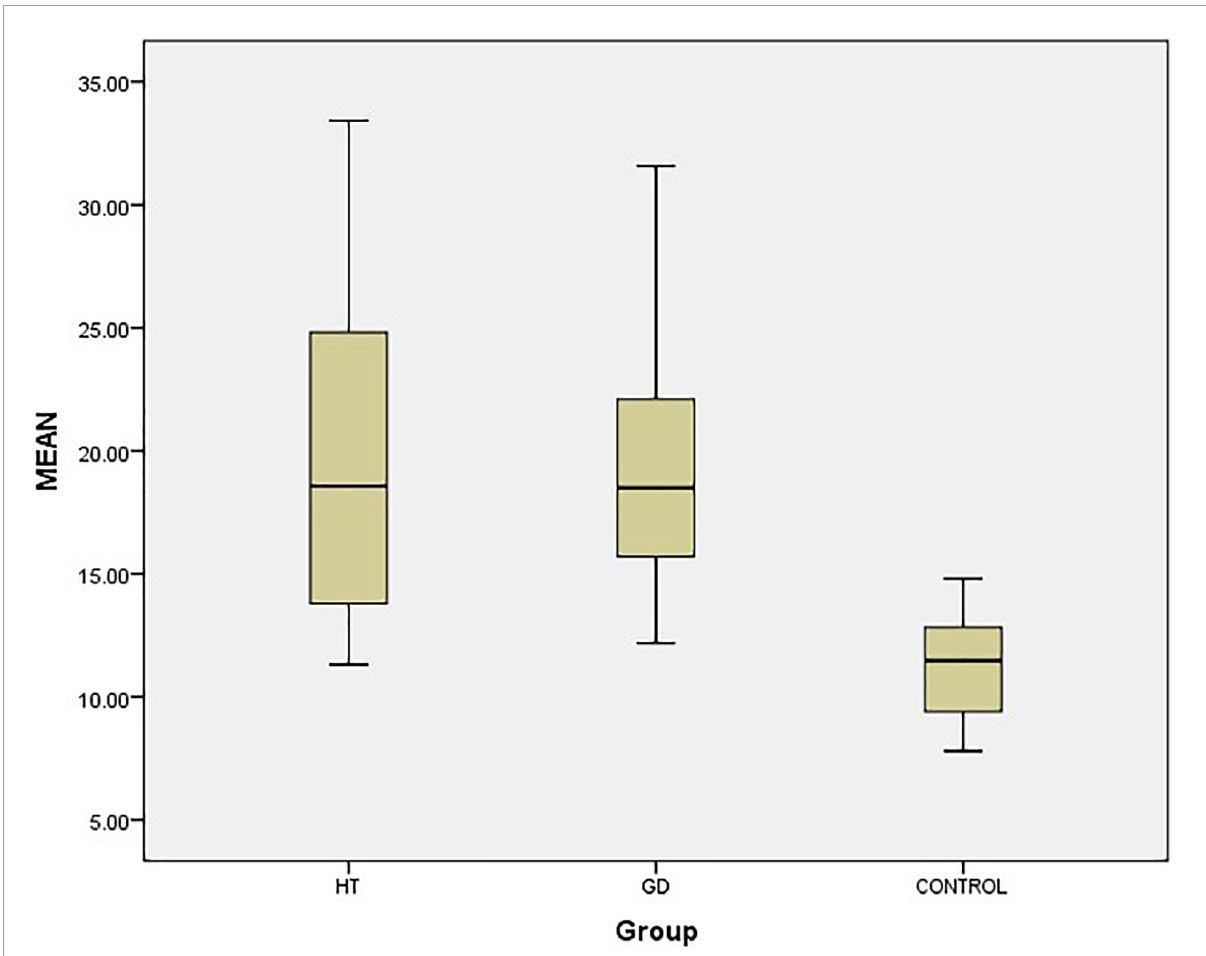
FIGURE2 Box-plot of thyroid STE-Mean value. The top and bottom line segments represent the maximum and minimum values of data, respectively, wherein the top and bottom line segments of the box graph represent the third quartile and the first quartile, respectively, and the thick line segment in the middle of the box graph represents the median of data. CONTROL: normal